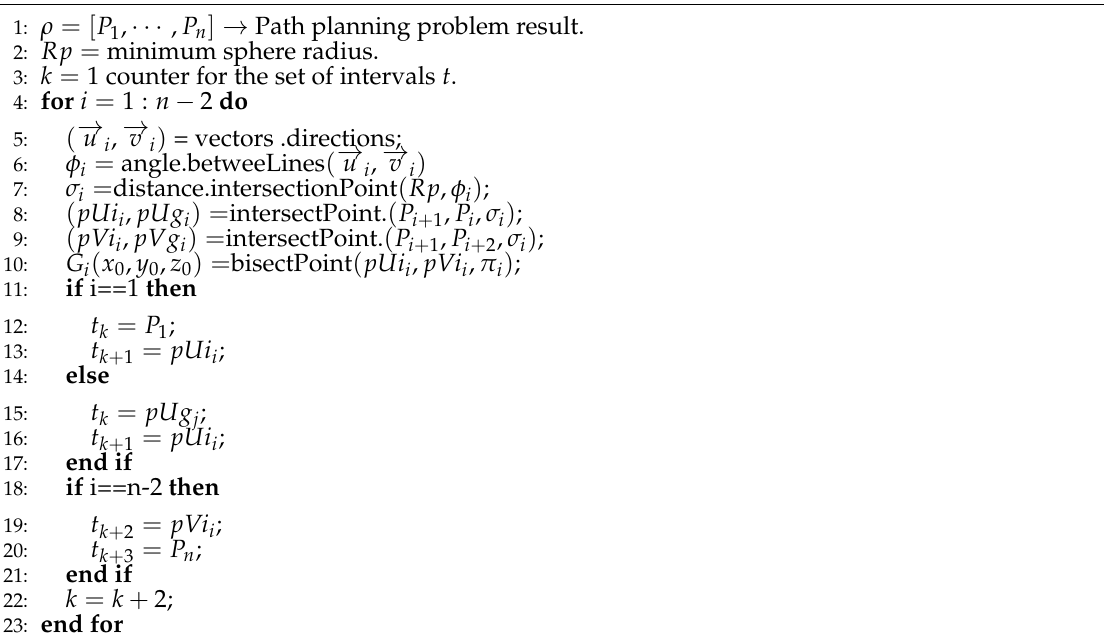
Algorithm 1 First set of G